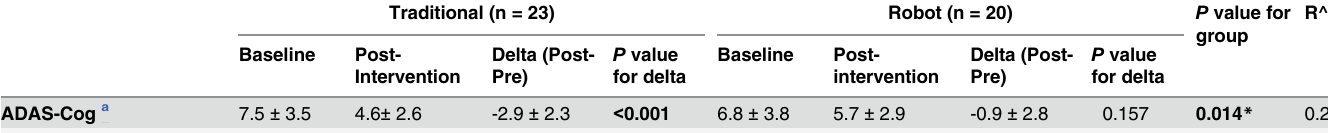
Table 4. Changes in cognitive functions between the traditional and the robot